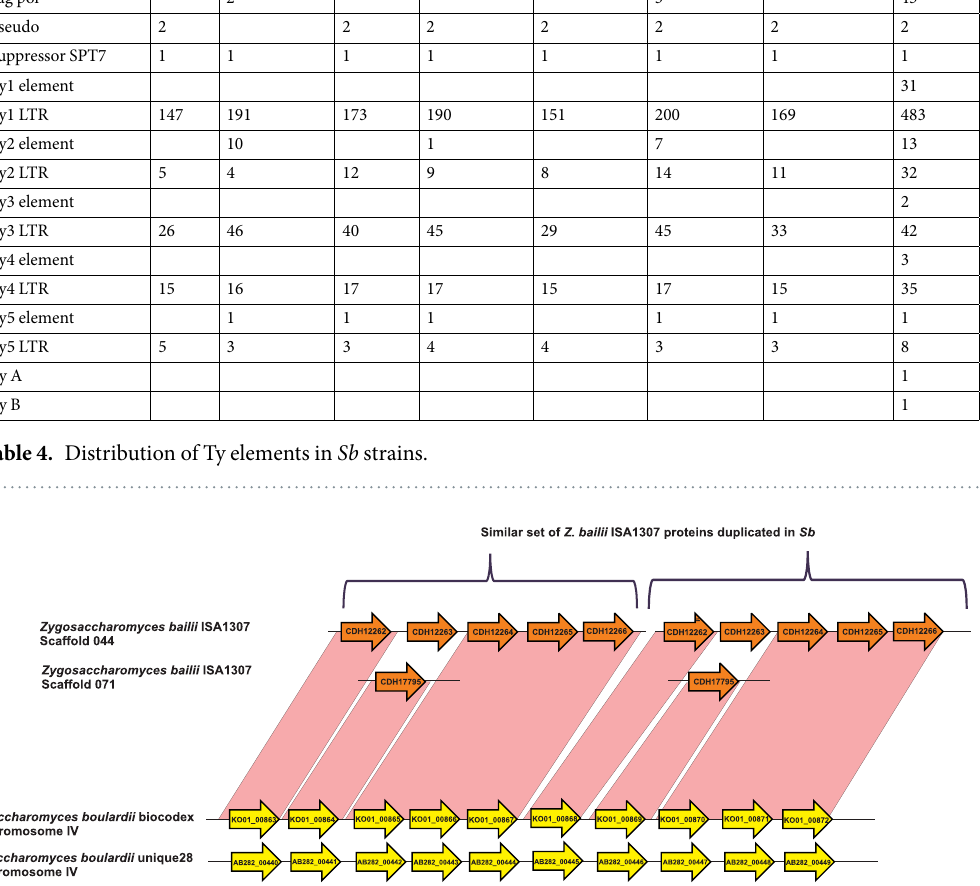
Figure 3. Introgression of five genes in two copies from Zygosaccharomyces bailii to Chromosome IV of Sb